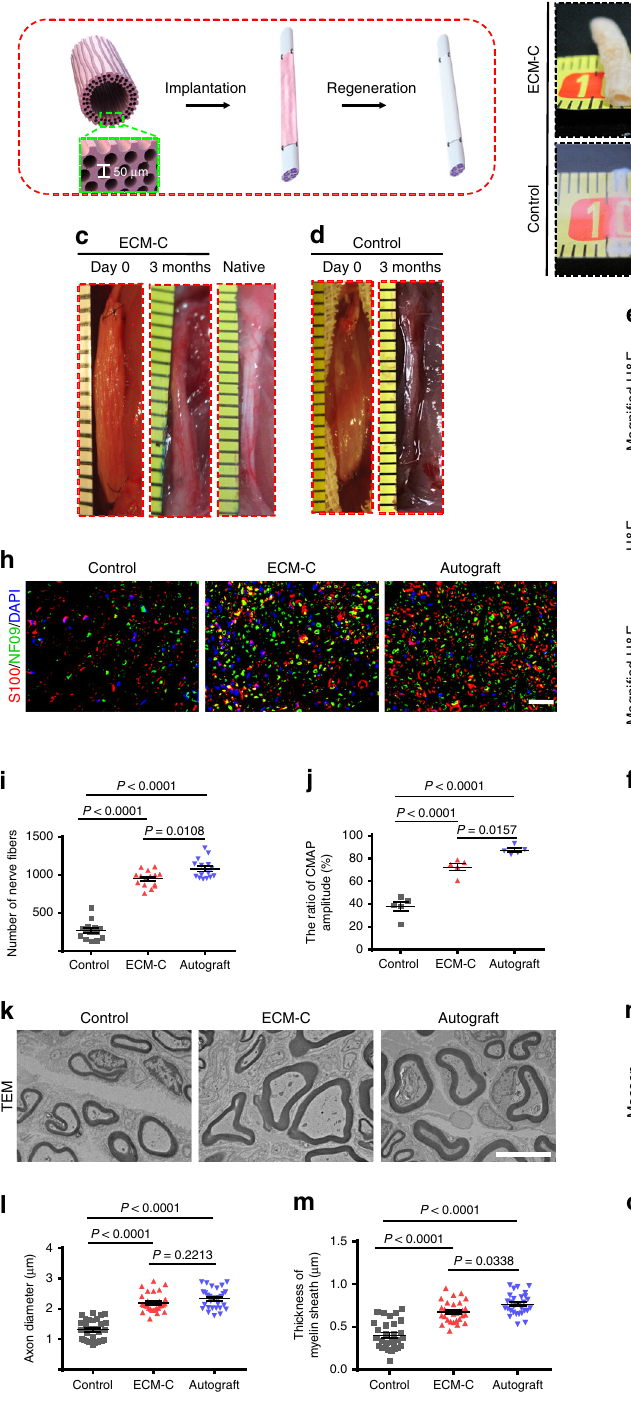
Vascular regeneration . To better induce the regeneration of arterial tissue with circumferential orientation for withstanding the pressure of the circulatory system, we therefore designed the tubular ECM-C with circumferentially oriented microchannels in the wall and evaluated in situ vascular regeneration and inte- gration with abdominal artery defects (Fig. 7a). The inner dia- meter of the vascular ECM-C was 1.8 ± 0.1 mm, and the thickness of the wall was 423.2 ± 21.3 μ m. The burst pressure of these scaffolds was 1489 ± 208 mmHg ( n = 4), close to that of human